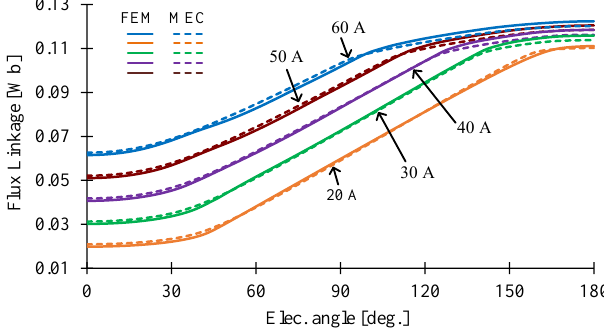
Figure 16. Static phase flux linkage characteristics at different